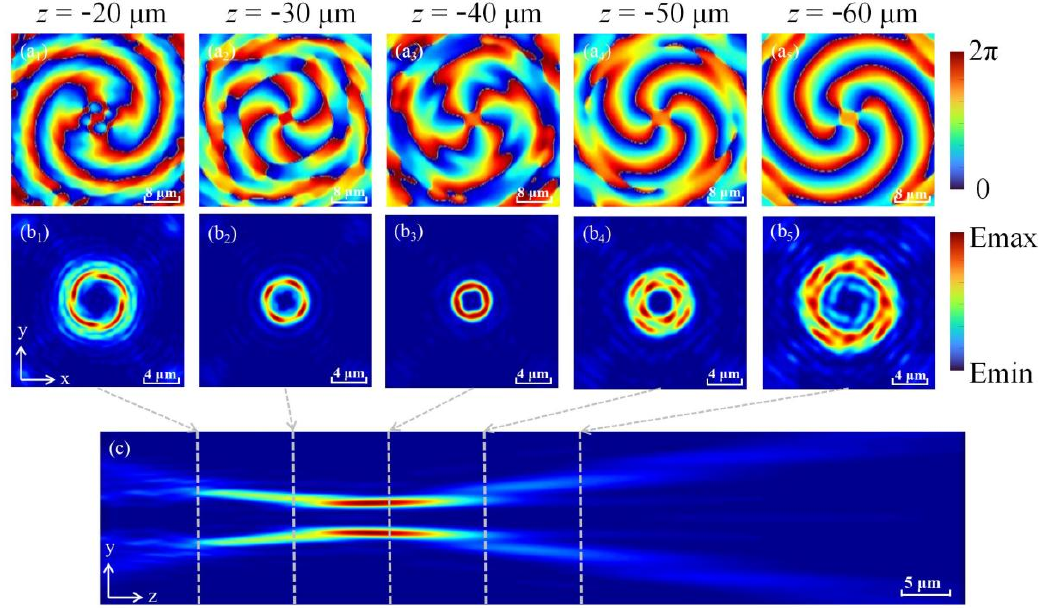
Figure 7. Schematic diagram of beam propagation with HOCP. The phase distribution ( a ) and the light field ( b ) diagrams of the XOY plane from z = − 20 µ m to z = − 60 µ m. ( c ) The optical field light field ( b ) diagrams of the XOY plane from z = − 20 μ m to z = − 60 μ m. ( c ) The optical field distri- distribution diagram of the HOCP beam in the YOZ bution diagram of the HOCP beam in the YOZ plane.